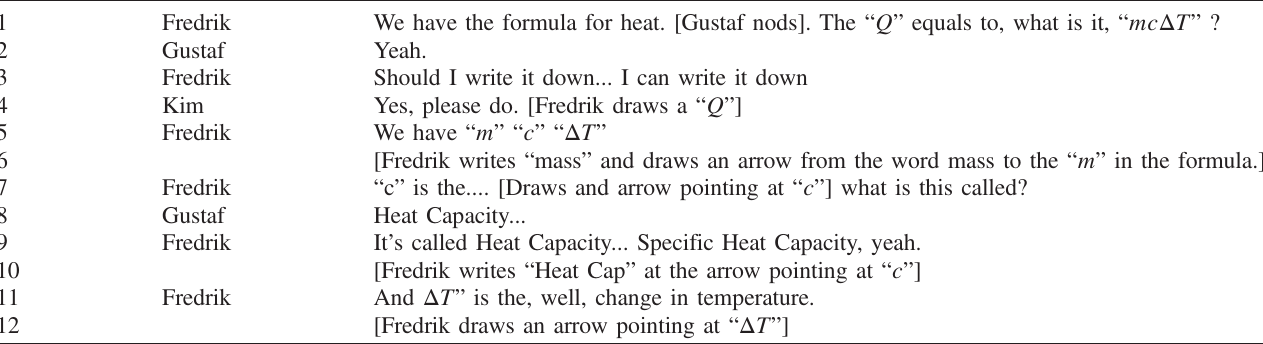
TABLE II. Transcript of a transduction from speech to formula of the semiotic material of thermal energy.